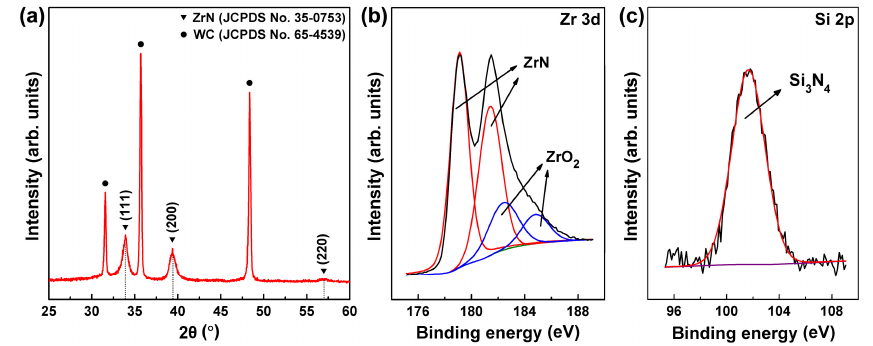
Figure 1. The ( a ) normal XRD pattern, ( b ) Zr 3 d , and ( c ) Si 2 p XPS spectra of the ZrN/Si 3 N 4 multilayer coating. multilayer coating.